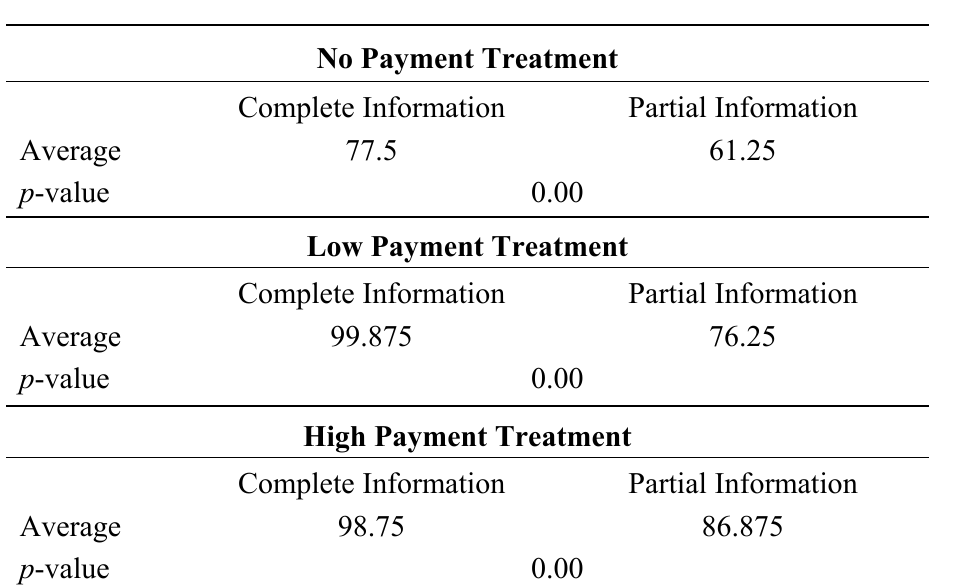
Table 5. Average frequencies of strategic votes and effect of